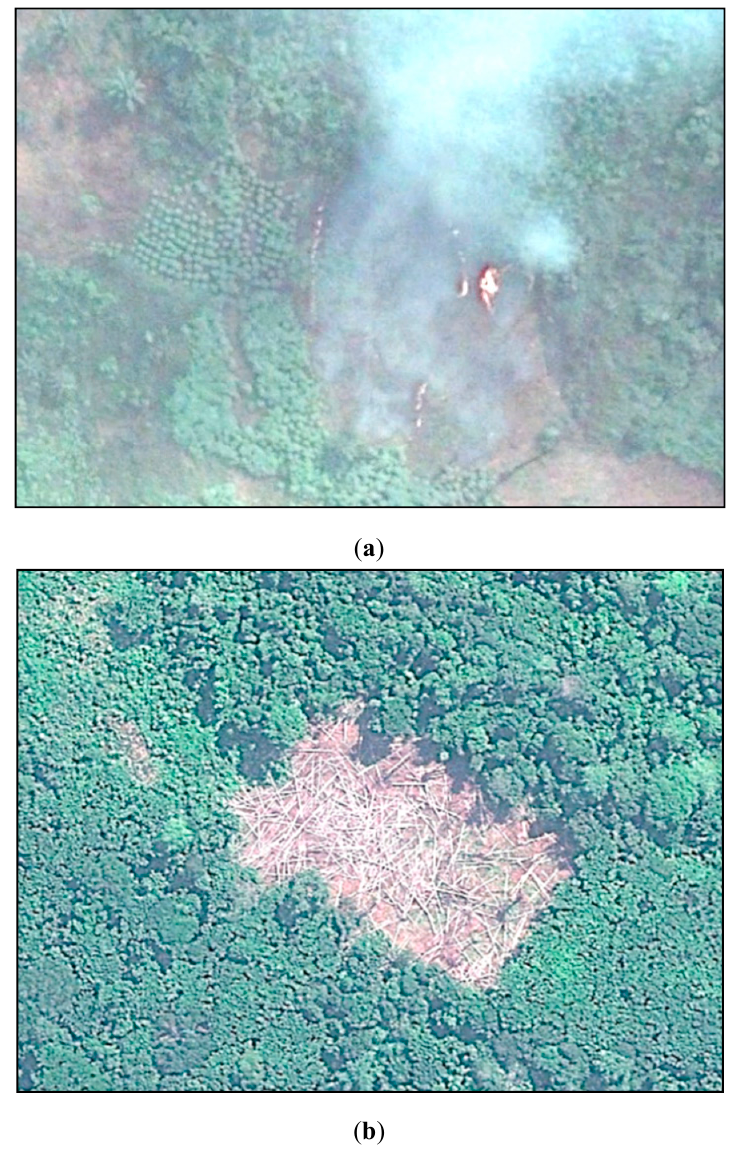
Figure 1. Examples of land cover visually interpretable in the imagery on Google Earth: ( a ) an area is being burned to clear vegetation residue and fertilize the soil, next to areas of active agriculture; ( b ) a patch of secondary forest that has been cleared.